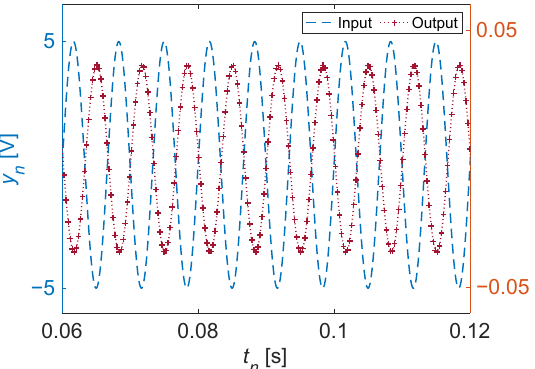
Figure 2. Dynamics of the studied actuator. Shown are the experimentally measured output signal, which is the actuator response to a periodic square-wave input signal, and the simulated output of Equation (19) given the same input signal.